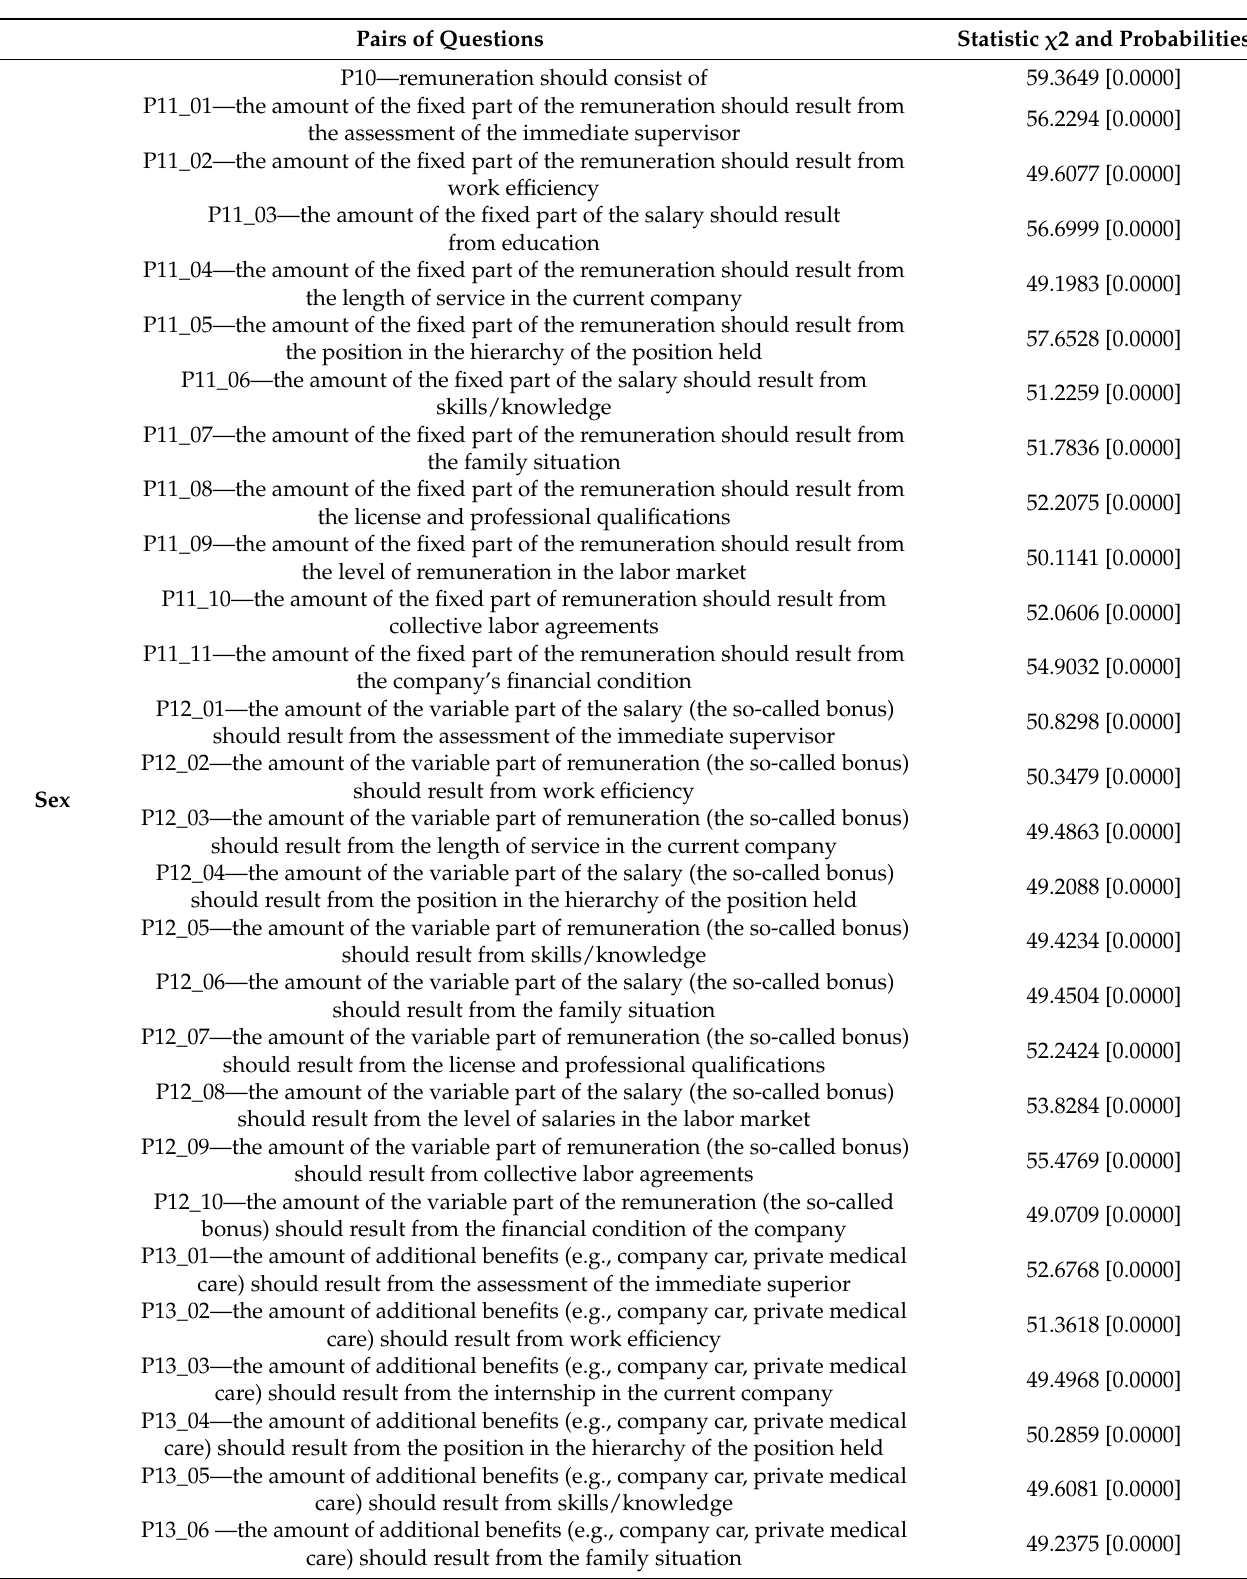
Table 1. The statistic value χ 2